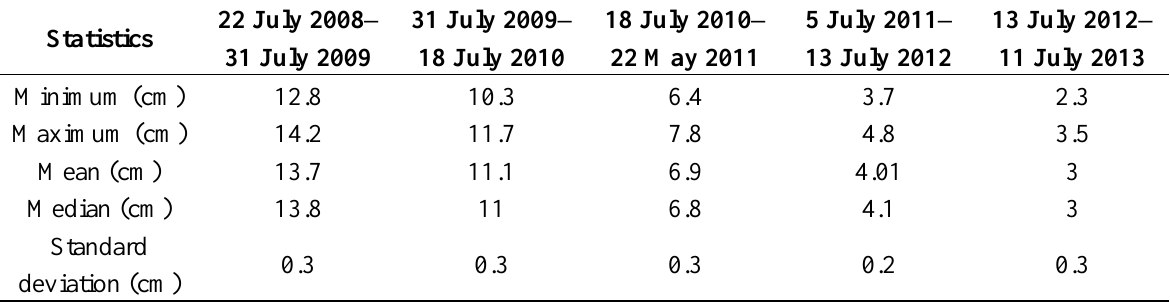
Table 4. Line of sight (LOS) uplift statistics within area of maximum displacement (red square in Figure 3a) for different periods. The first three columns refer to the Small BAseline Subsets (SBAS) analysis of Lubitz et al. [3] (24 slowly-decorrelating filtered phase (SDFP) pixels within the defined area) and the last two represent the period under investigation of this study (27 SDFP pixels within the defined